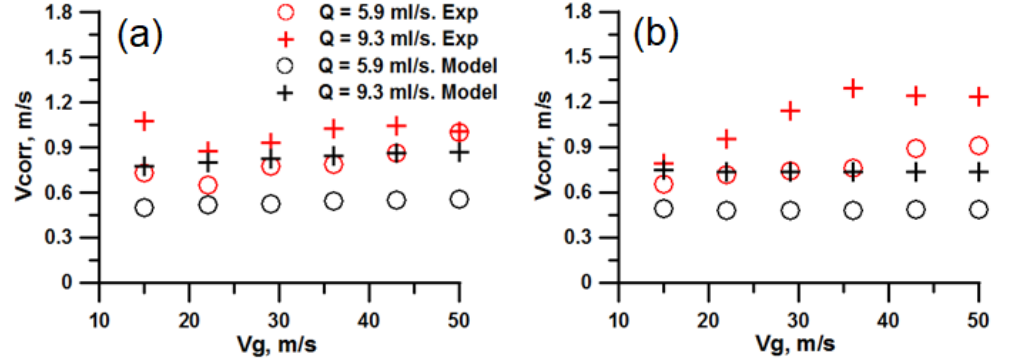
Figure 10. Comparison of the measured against the calculated wave velocity: ( a ) water; and ( b ) WGS2.